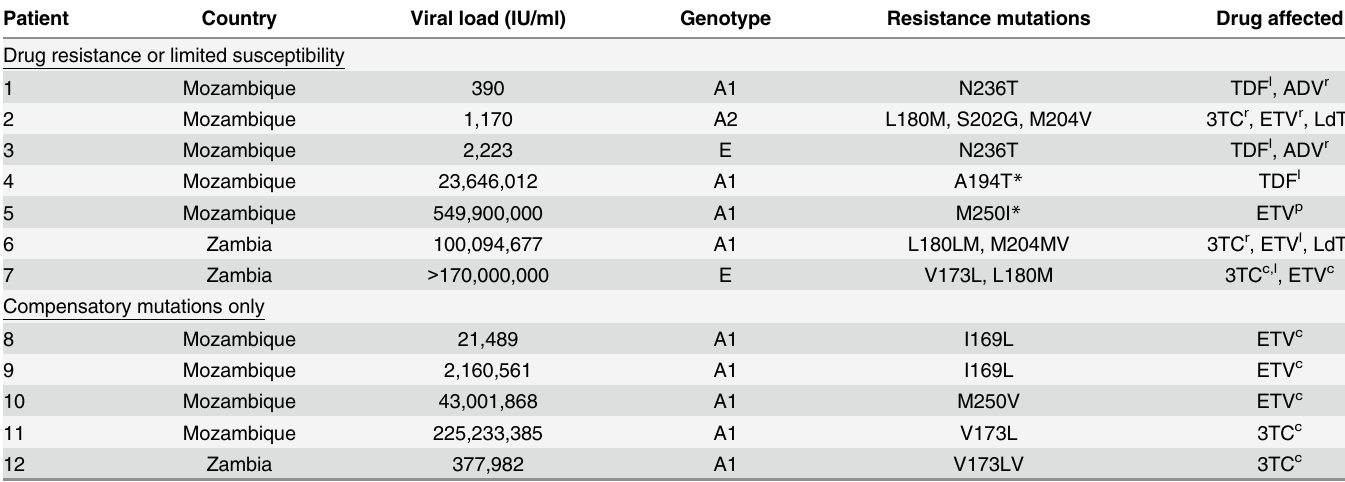
Table 2. Baseline HBV drug resistance